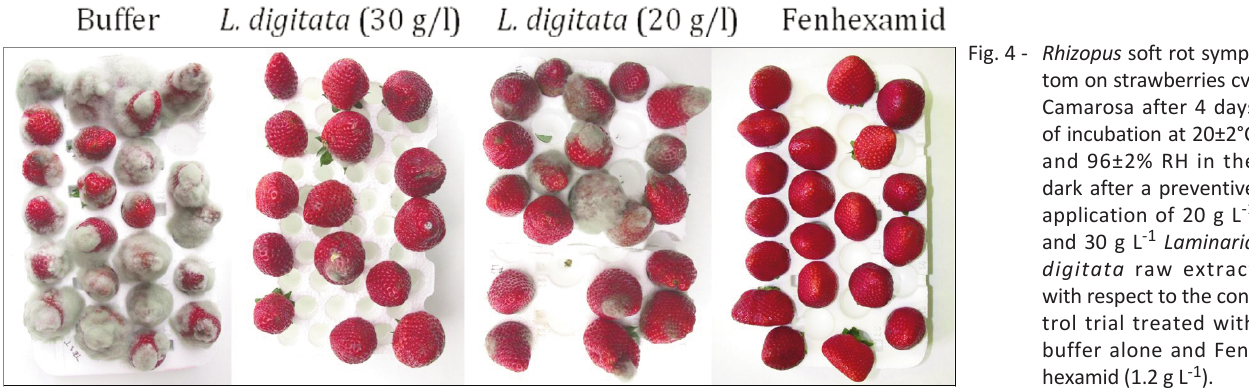
Table 2 - Peroxidase (POD) activity in strawberries inoculated with R. stolonifer and preventively treated with 30 g L -1 Laminaria digitata un-fractionated extract. POD assessment was carried out after one-day and five-days of incubation at 20±2°C and 98% RH in the dark